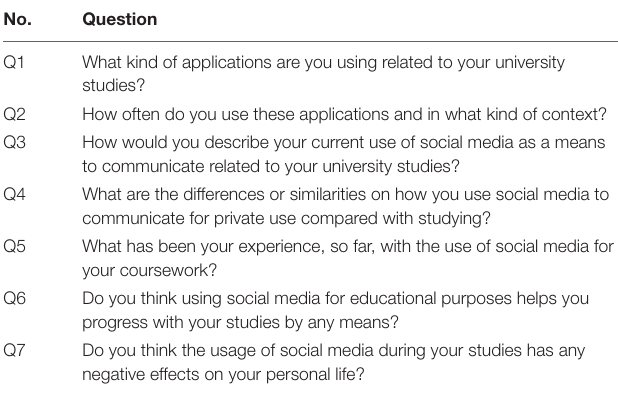
TABLE 1 | List of questions that guided the semi-structured interviews.